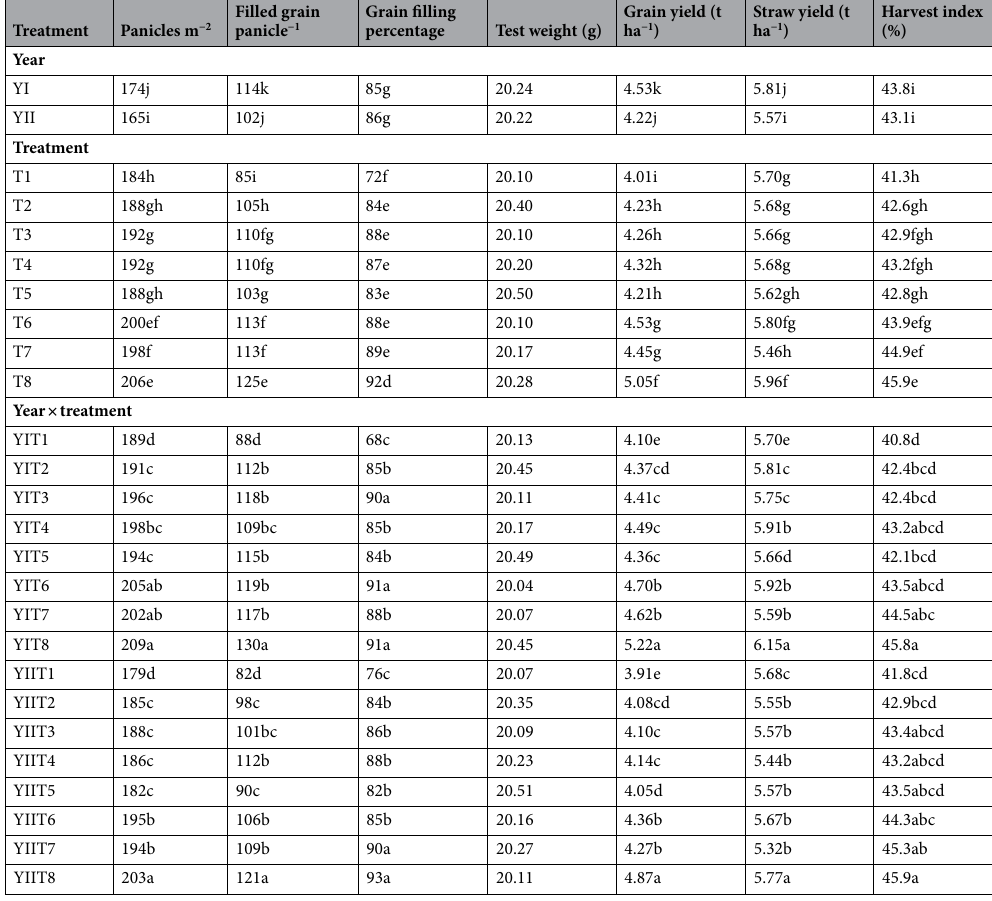
Table 4. Effect of seed priming on yield and yield components of direct-seeded rice in a field experiment during 2019 (YI) and 2020 (YII). Within a column, means followed by the same letter are not different at the 0.05 level of probability. Treatments detail in Table